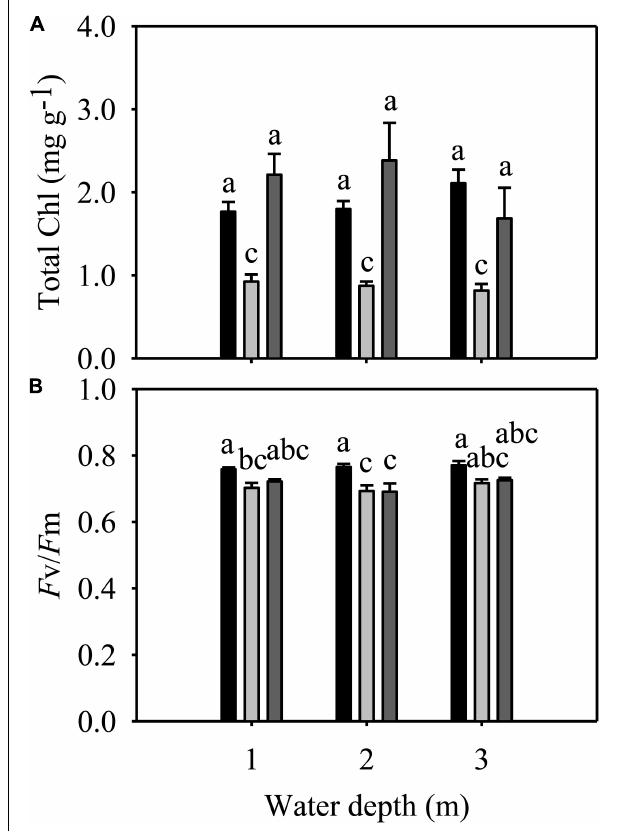
FIGURE 4 | Changes in the total chlorophyll content (A) and F v/ F m (B) of three macrophytes. The data presented are the mean ± 1SE ( n = 7). Means with different small letters are significantly different at P < 0.05 among different